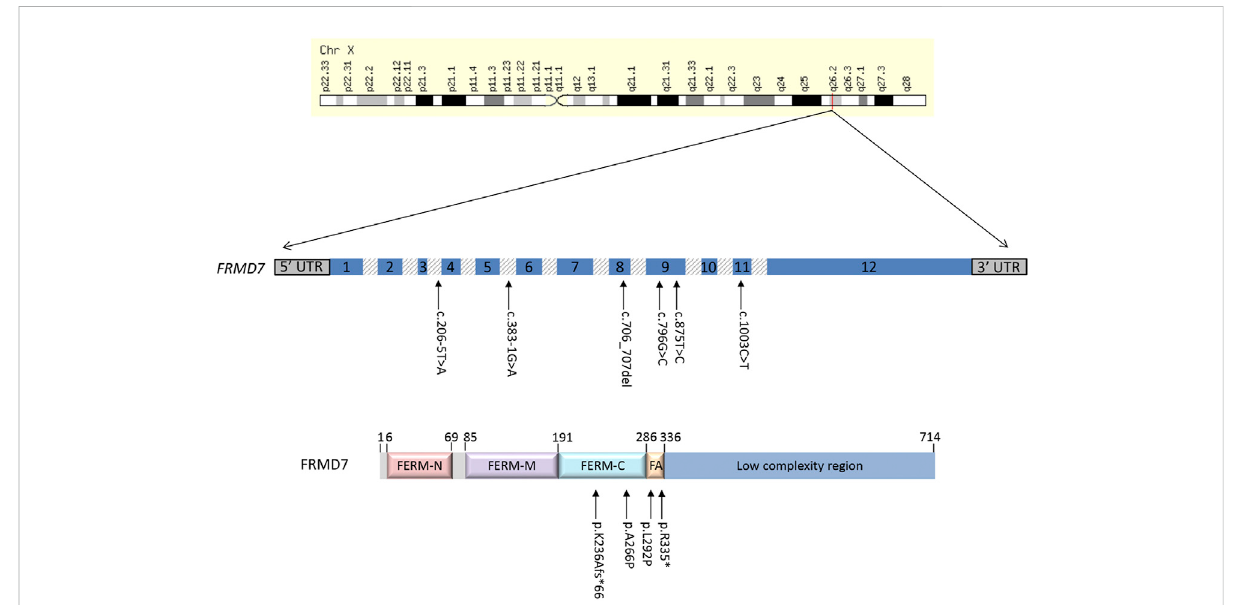
FIGURE 2 Schematic representation of the FRMD7 gene and protein highlighting mutations (arrows) in patients with idiopathic infantile nystagmus (IIN). Exons are indicated with numbered boxes, and introns, which are not in proportion, appear shaded in gray.